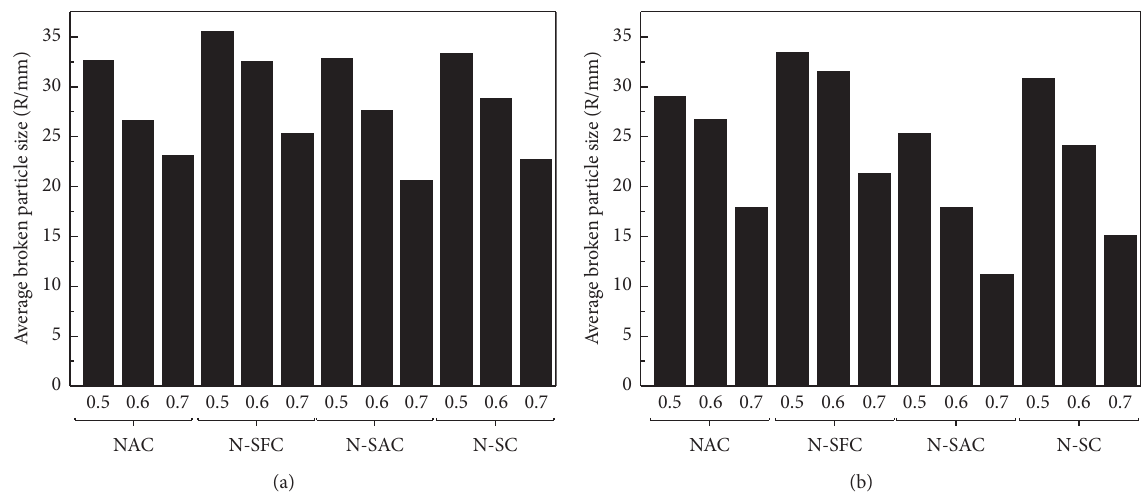
Figure 15: Average particle size after SHPB impact. (a) C30 groups. (b) C40 groups.